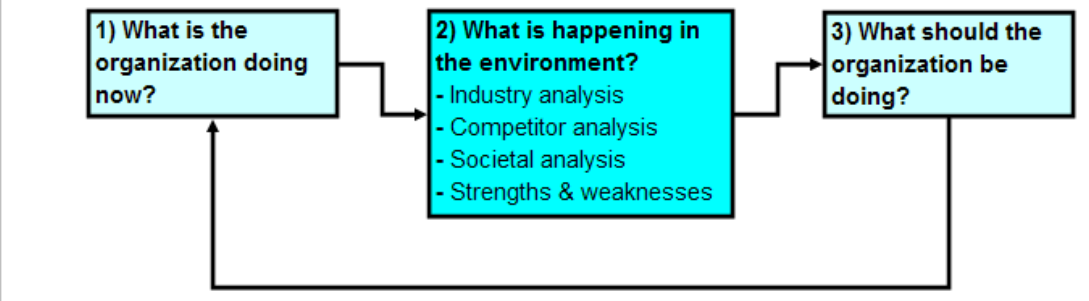
Figure 1 Process for formulating a competitive strategy (Porter